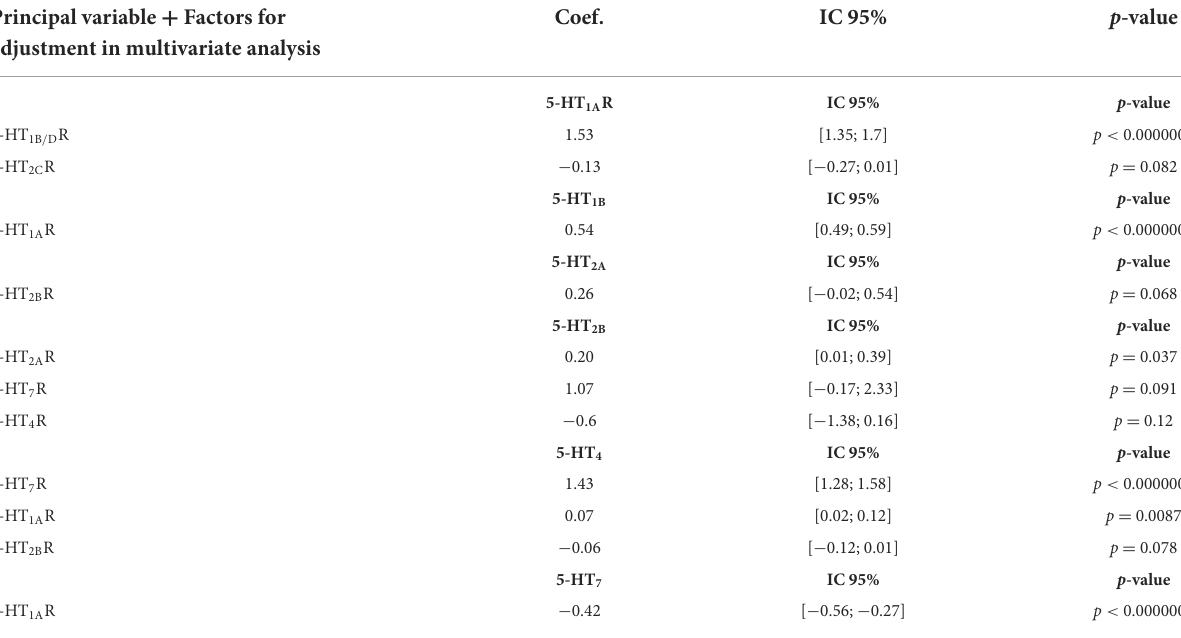
TABLE 4 Factors controlling the expression of specific 5-HTR based on multivariate analysis after adjustment for all other 5-HTRs and implantation sites (see also Figure 4). Principal variable + Factors for adjustment in multivariate analysis